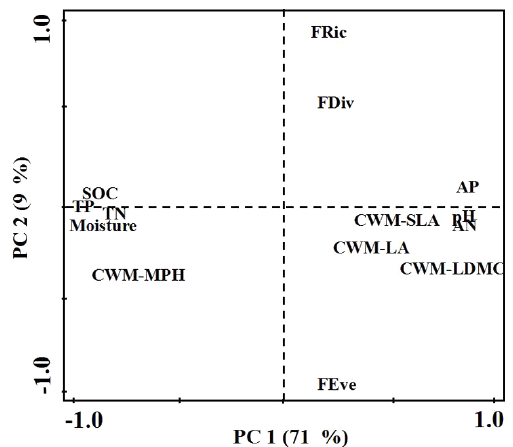
Figure 5. Principal component analysis combining data on soil properties, CWM trait, and functional diversity. Only the first two axes (PC1 and PC2), which account for 80% of the total variation, are retained here. The first axis can account for 71% of the total in- ertia, and it differentiates communities according to soil moisture: the communities of higher soil moisture showed higher SOC, TN, TP, and CWM-MPH, while the communities of lower soil moisture showed higher AN, AP, pH, CWM-LA, CWM-SLA, and CWM- LDMC. The second axis can account for 9% of the total inertia, and it showed that functional richness (FRic) had a positive relationship with functional divergence (FDiv) but a negative relationship with functional evenness